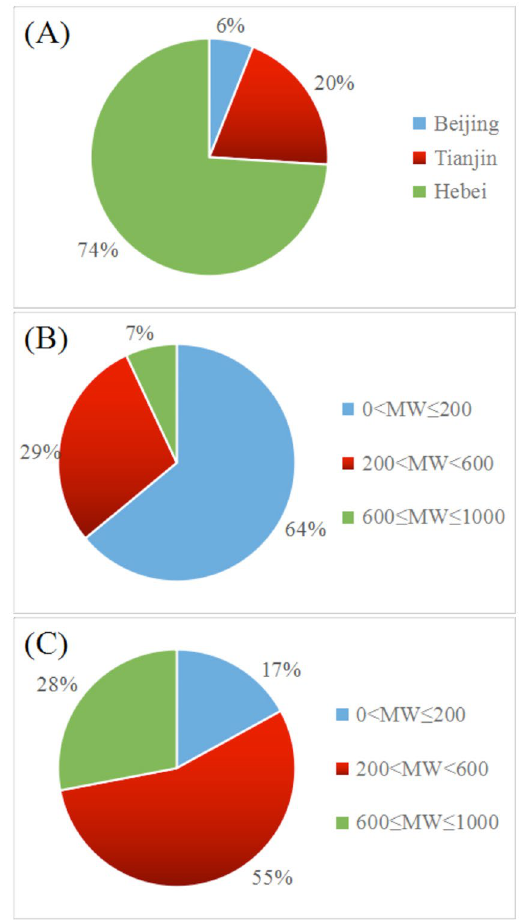
Figure 2. Proportional distributions of thermal power plants in the BTH region in 2013 based on ( A ) unit capacity for the three areas, ( B ) the distribution of units by MW capacity, and ( C ) the unit capacity for the entire